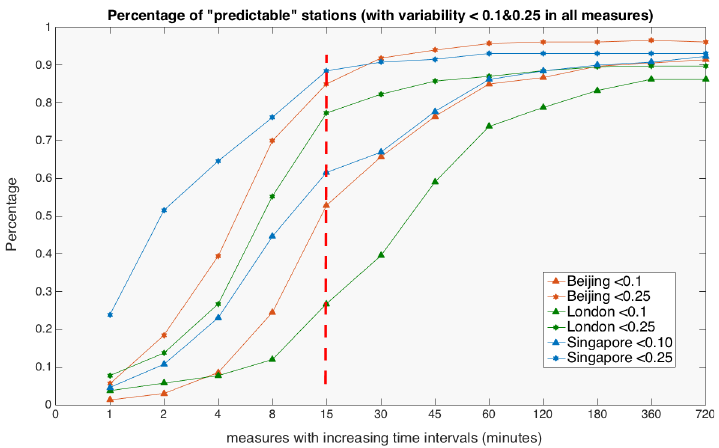
Fig 7. Comparative analysis of predictable trips origin and destinations. Note: A critical point exists at 15 minutes in all three cities as a universal pattern, which implies how closely we can predict future event.